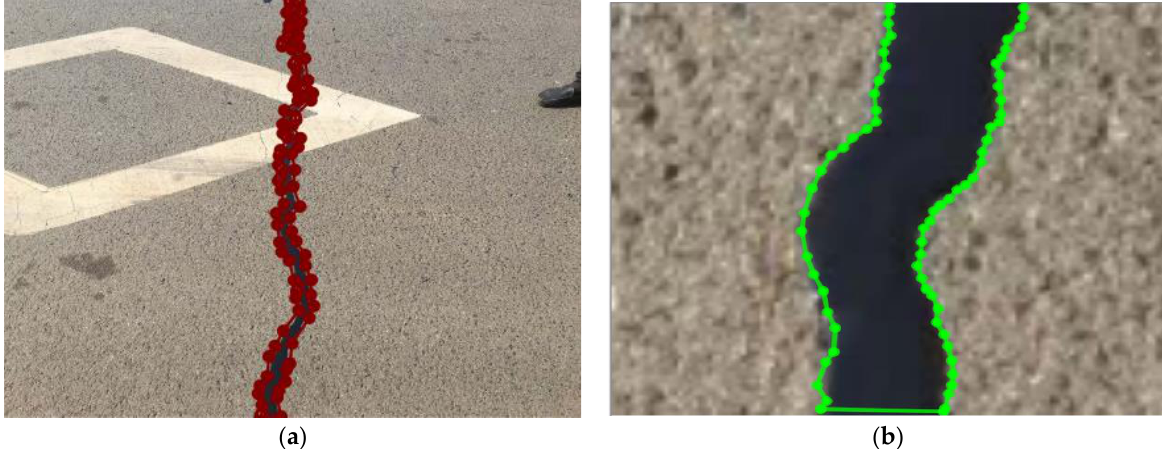
Figure 2. Crack labeling procedure. ( a ) Crack labeling; ( b ) Completed crack labeling.